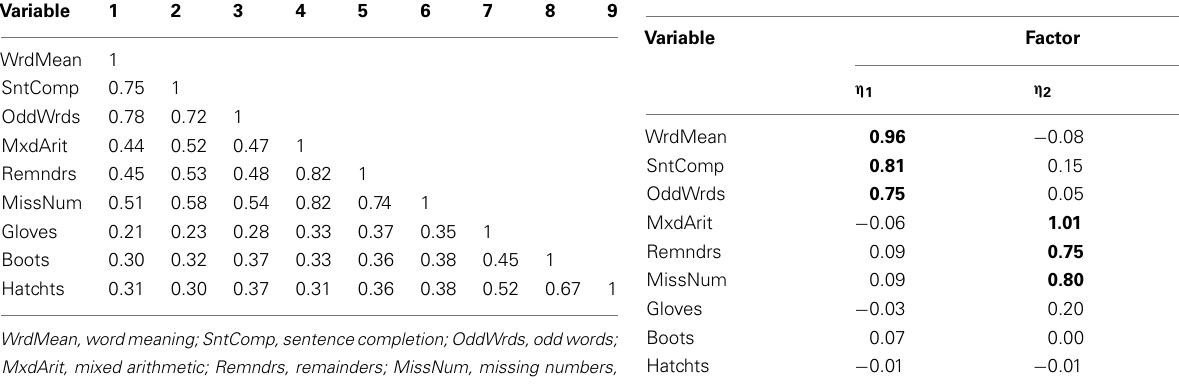
Table 3 | Sample factor loading matrix (multivariate normal data, no outlying